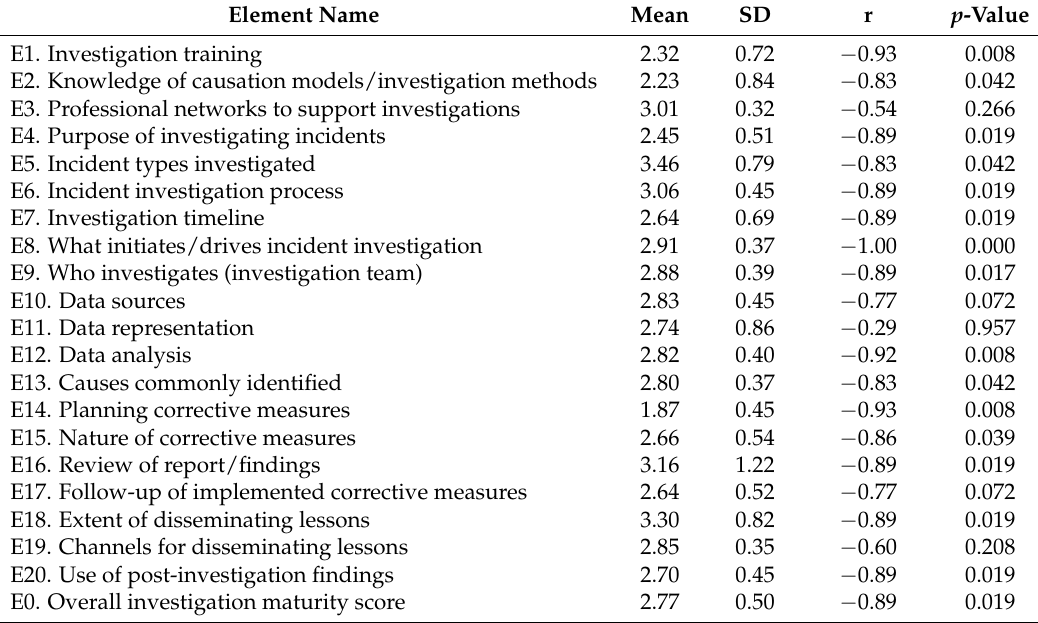
Table 7. Spearman’s correlation (r) between incidence rate and incident investigation maturity score (N = 5, significant at p <